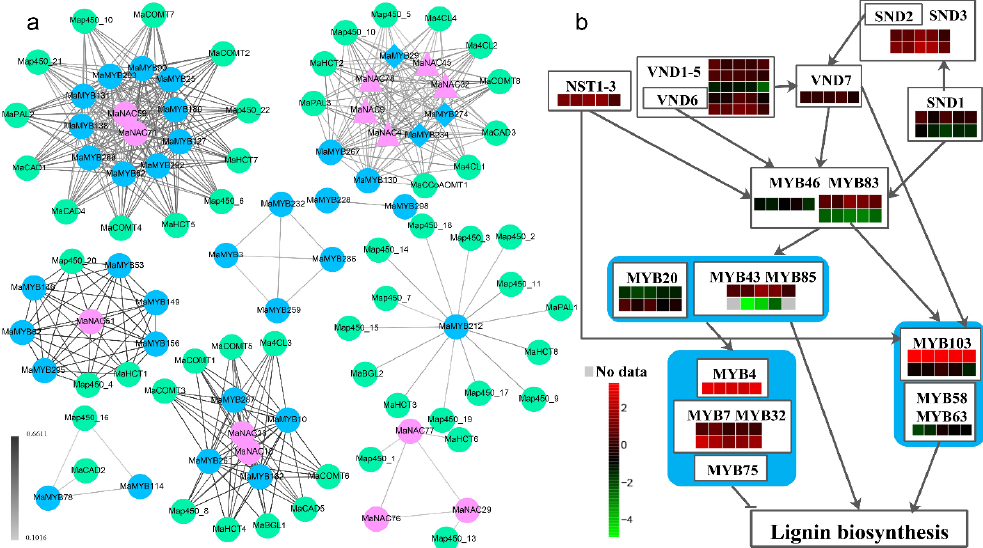
Figure 9. Coexpression network of MaNAC , MaMYB and lignin biosynthesis-related genes and their regulatory network. ( a ) Coexpression network of MaNAC , MaMYB and lignin biosynthesis-related genes. The green circle represents lignin biosynthesis-related genes that are expressed downstream of NACs and MYBs, the blue circle represents MYB TFs, the pink circle represents NAC TFs, the pink triangle represents lignin biosynthesis-related NAC genes, and the blue rhombus represents lignin biosynthesis-related MYB genes. 4CL: 4-coumarate CoA Ligase, BGL: β-glucosidase, CAD: cinnamyl alcohol dehydrogenase, CCoAOMT: caffeoyl CoA O-methyltransferase, COMT: caffeic acid O-methyltransferase, HCT: hydroxycinnamoyl transferase, PAL: phenylalanine ammonia-lyase. The color of the line represents the weight value between two nodes. ( b ) Regulatory network of MaNAC , MaMYB and lignin biosynthesis-related genes. The heatmap below the gene name shows the gene expression pattern of five leaf samples. The heatmap represents the gene number in the horizontal direction and the expression level in the vertical direction for five leaf samples.